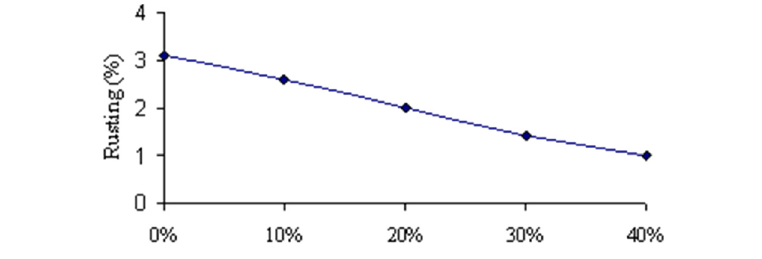
Figure 4: Degree of resting for painted samples based on modi fi ed and unmodi fi ed alkyd primer formulation.